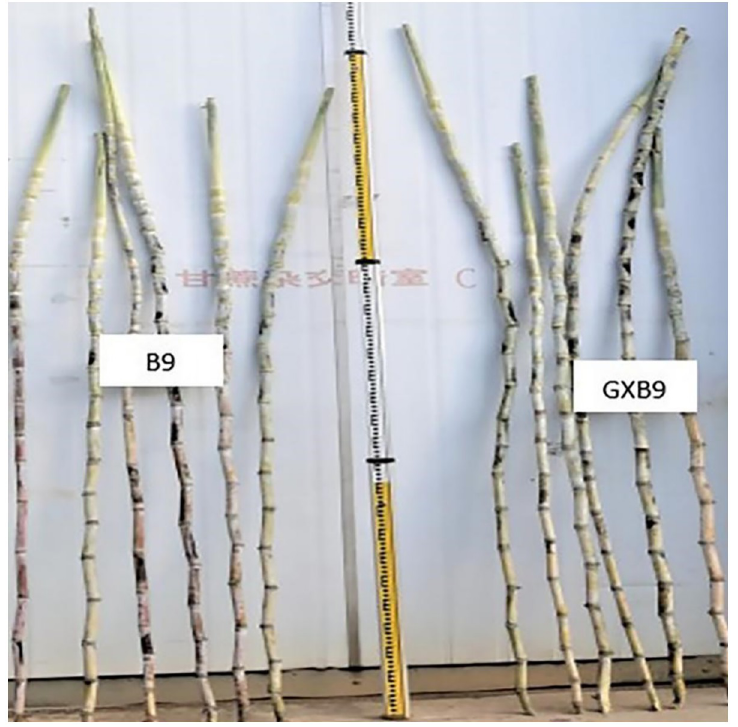
Fig 4. General view of the stalks in GXB9 and B9 at mature